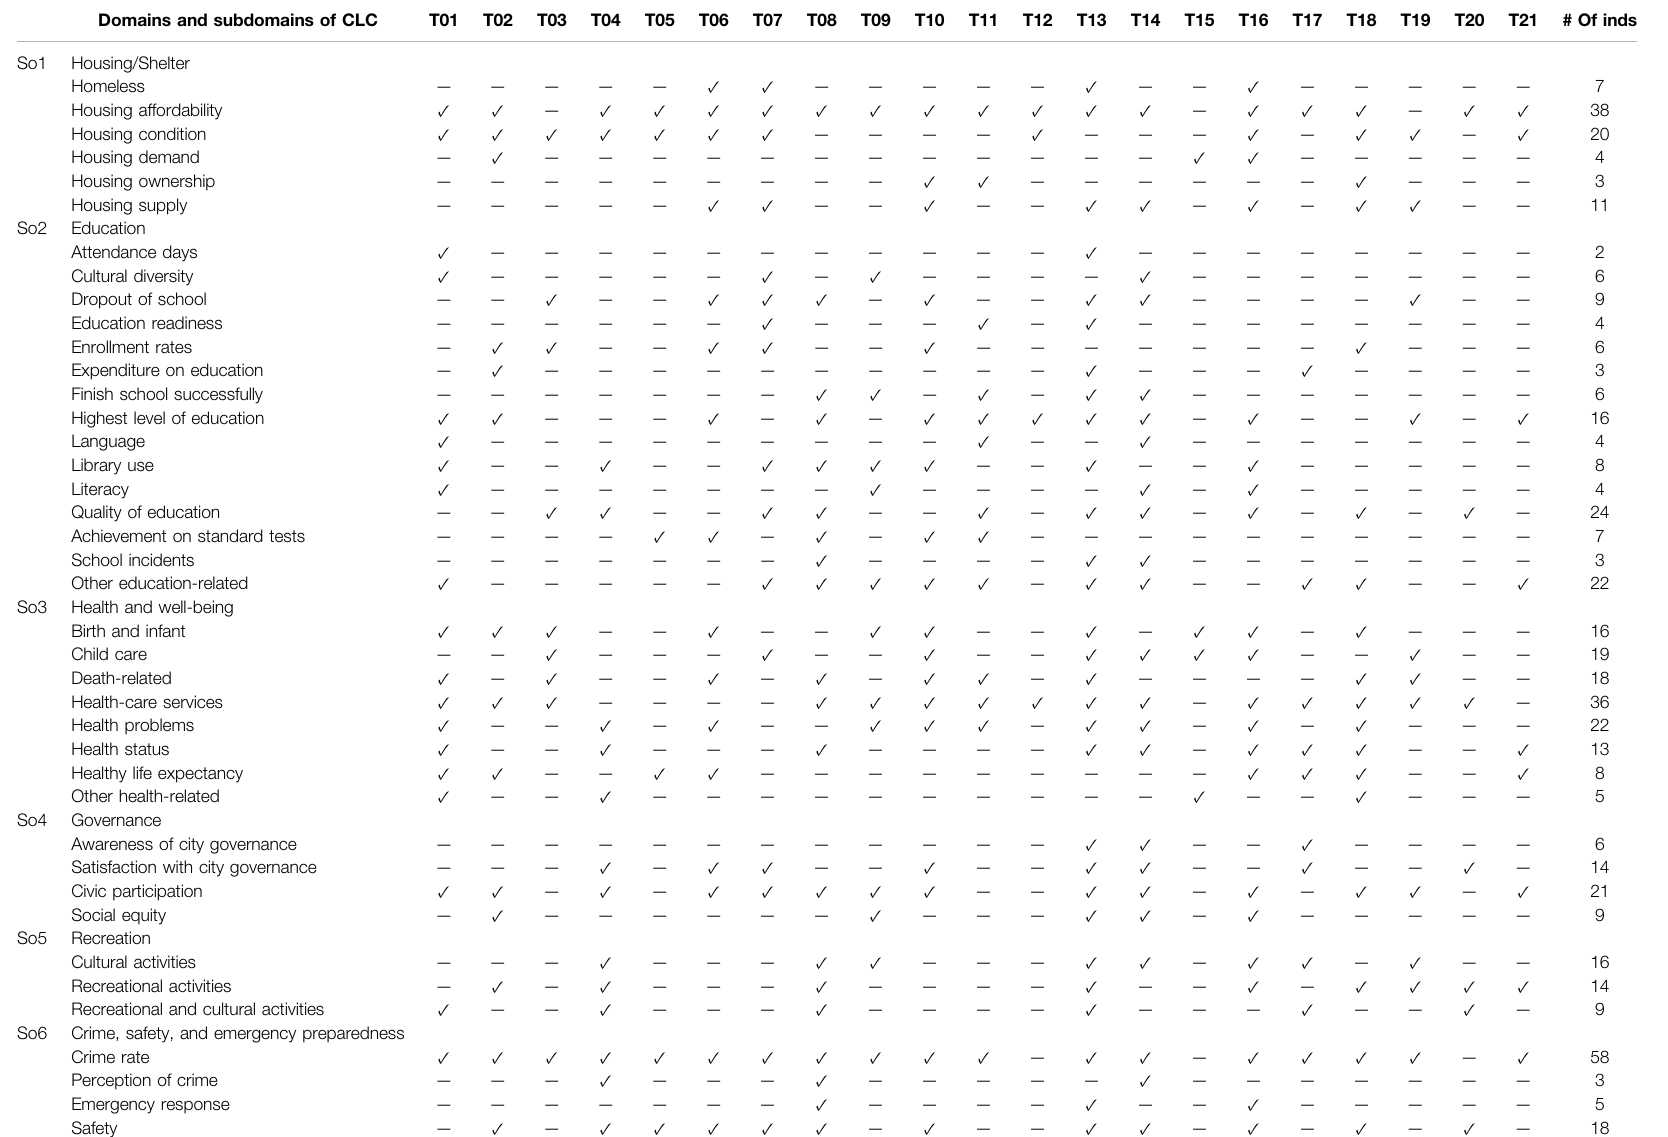
TABLE 4 | Coverage analysis of the 21 tools relative to QOL CLC – social-related criteria. Domains and subdomains of CLC